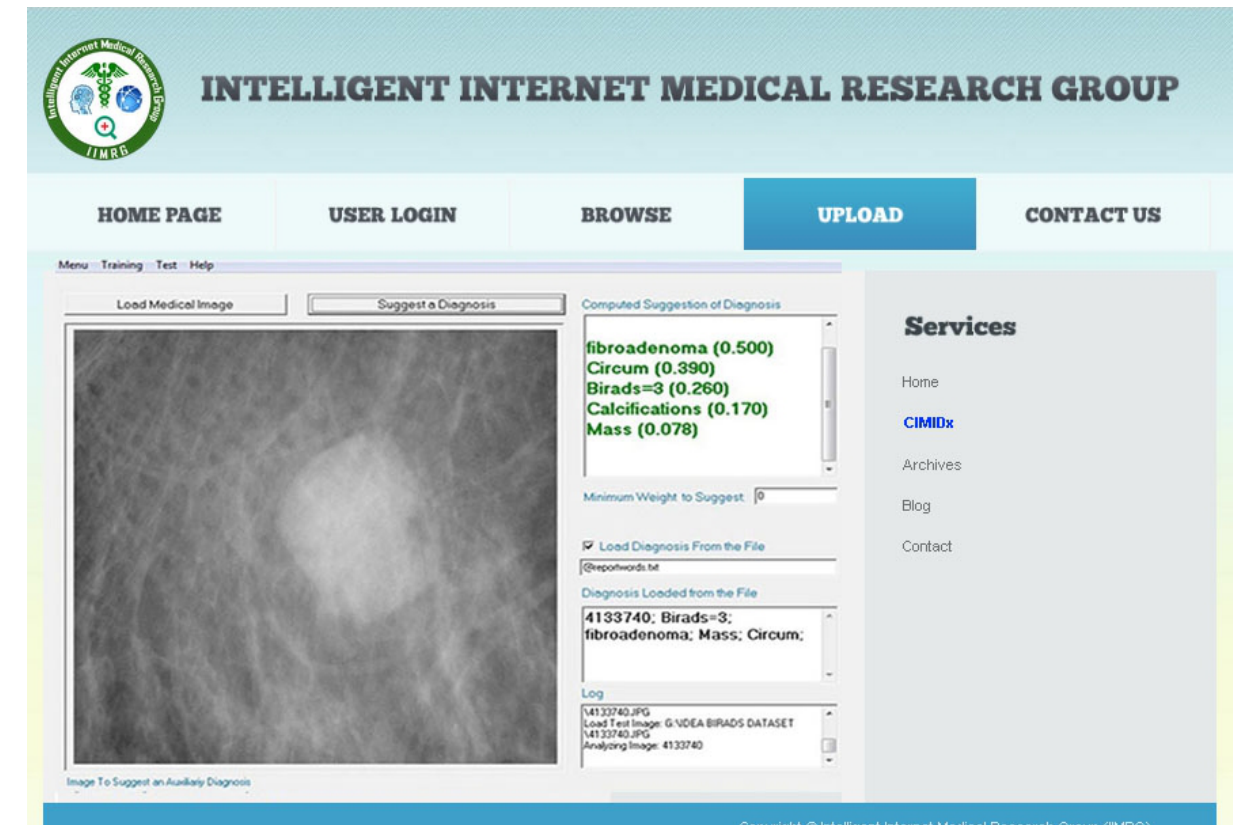
Figure 8. Implementation details of the CIMIDx